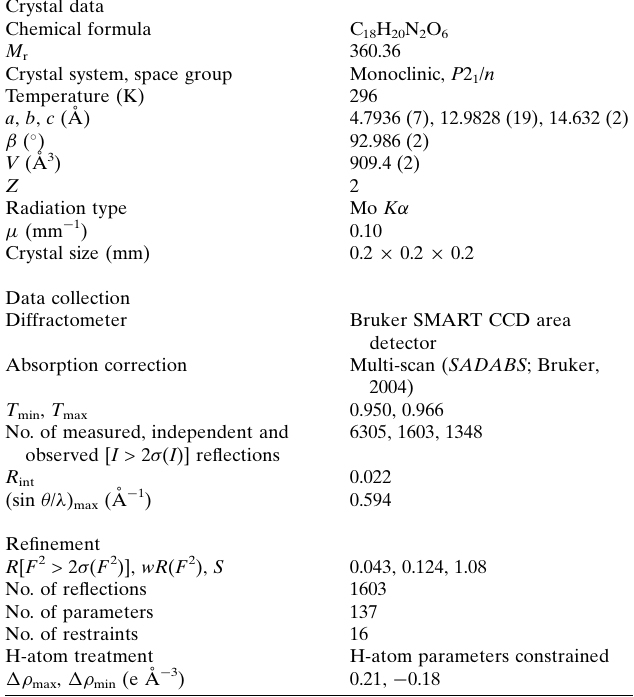
Figure 1 The molecular structure of the title molecule, with displacement ellipsoids drawn at the 50% probability level.